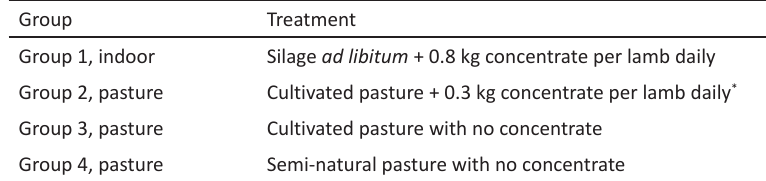
Table 1. Feeding strategies used for groups